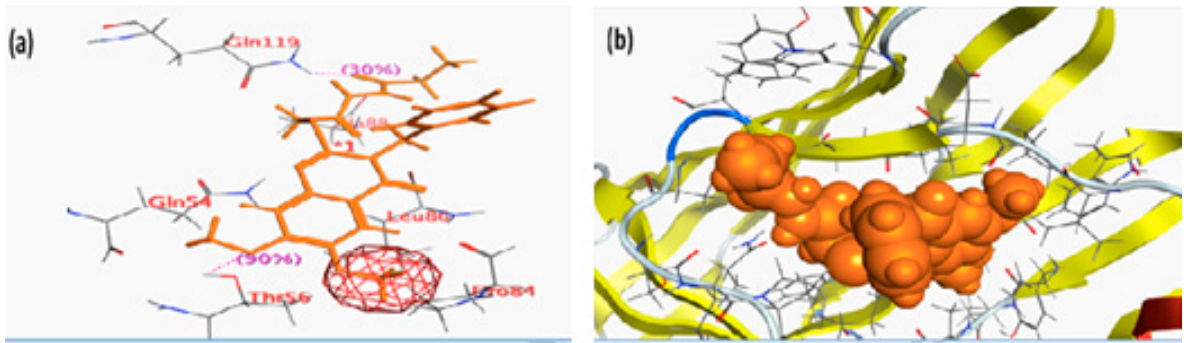
Figure 3 . ( a ) The interaction and binding of the most active (orange) with amino acid residues in the diazepam-binding pocket of the GABAA receptor. ( b ) The aligned conformation of the most active compound (space-filled) occupying the diazepam-binding pocket of the GABAA receptor [29]. Patel et al. (2016) studied a series of quinazoline derivatives which were synthe- sized, virtually screened, and evaluated for anticonvulsant activity against electrically and chemically induced seizures. Compound ( 32 ) was found to possess the most